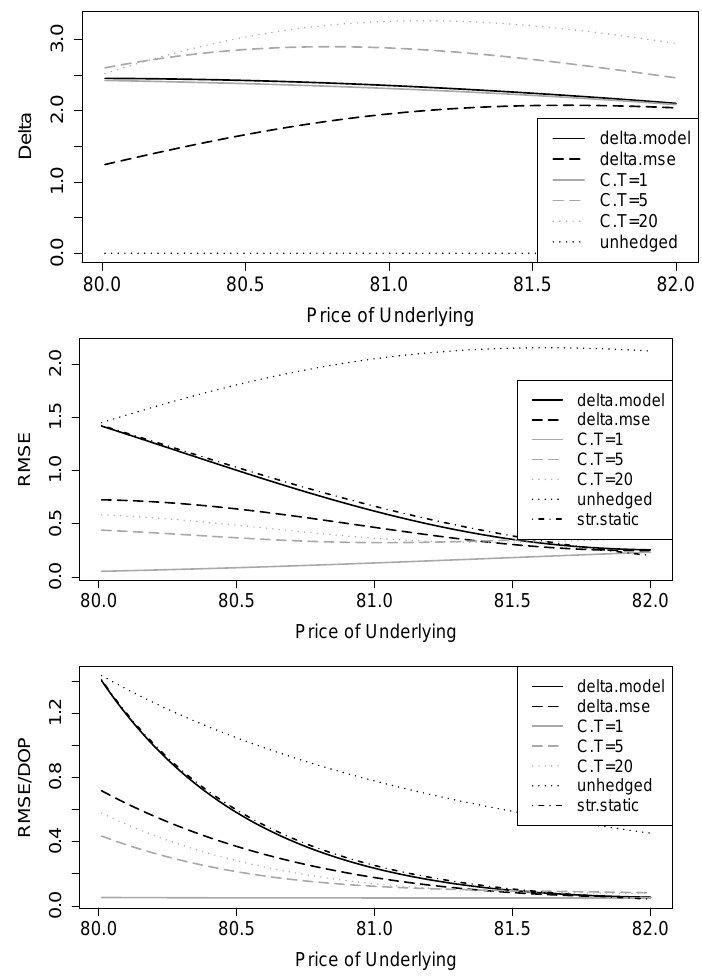
Figure 5. Black–Scholes model with overnight trading gap: deltas, absolute and relative root mean squared hedging errors. Hedging object is a down-and-out put with K = 100, B = 80, and T = 20 days; the hedging period is ∆ t = 1 day. The hedging strategies are standard Black–Scholes delta (delta.model), MSE delta using the underlying (delta.mse), MSE delta using vanilla calls with time to maturity of 1 (C.T = 1), 5 (C.T = 5), and 20 (C.T = 20) days, strike-spread static hedging (str.static), and no hedging